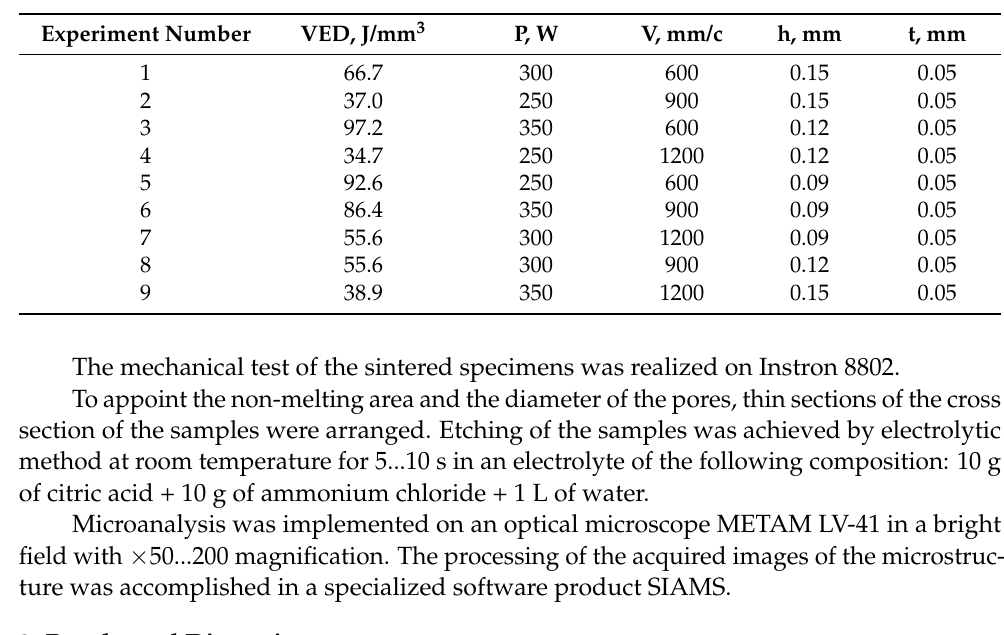
Table 2. The experimental plan.